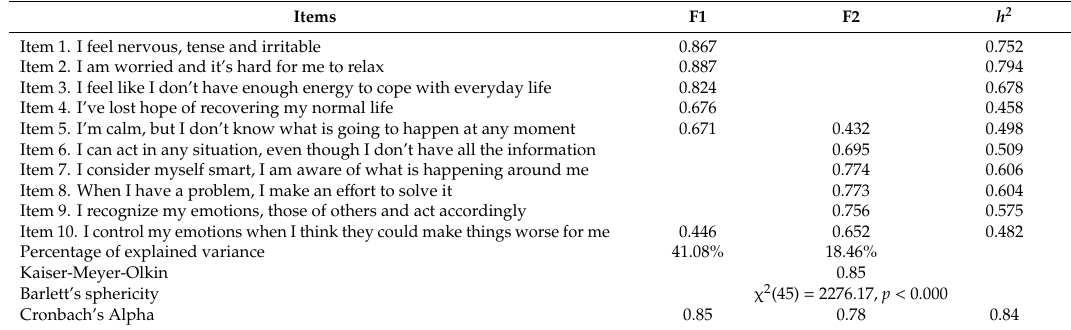
Figure 2. Scree plot of factor analysis for the ADAPTA-10 GF Model. Table 3. Factor structure, communalities ( h 2 ) eigenvalues, Cronbach’s alpha and percentage of explained variance ( n = 583). Extraction method: Factoring of principal